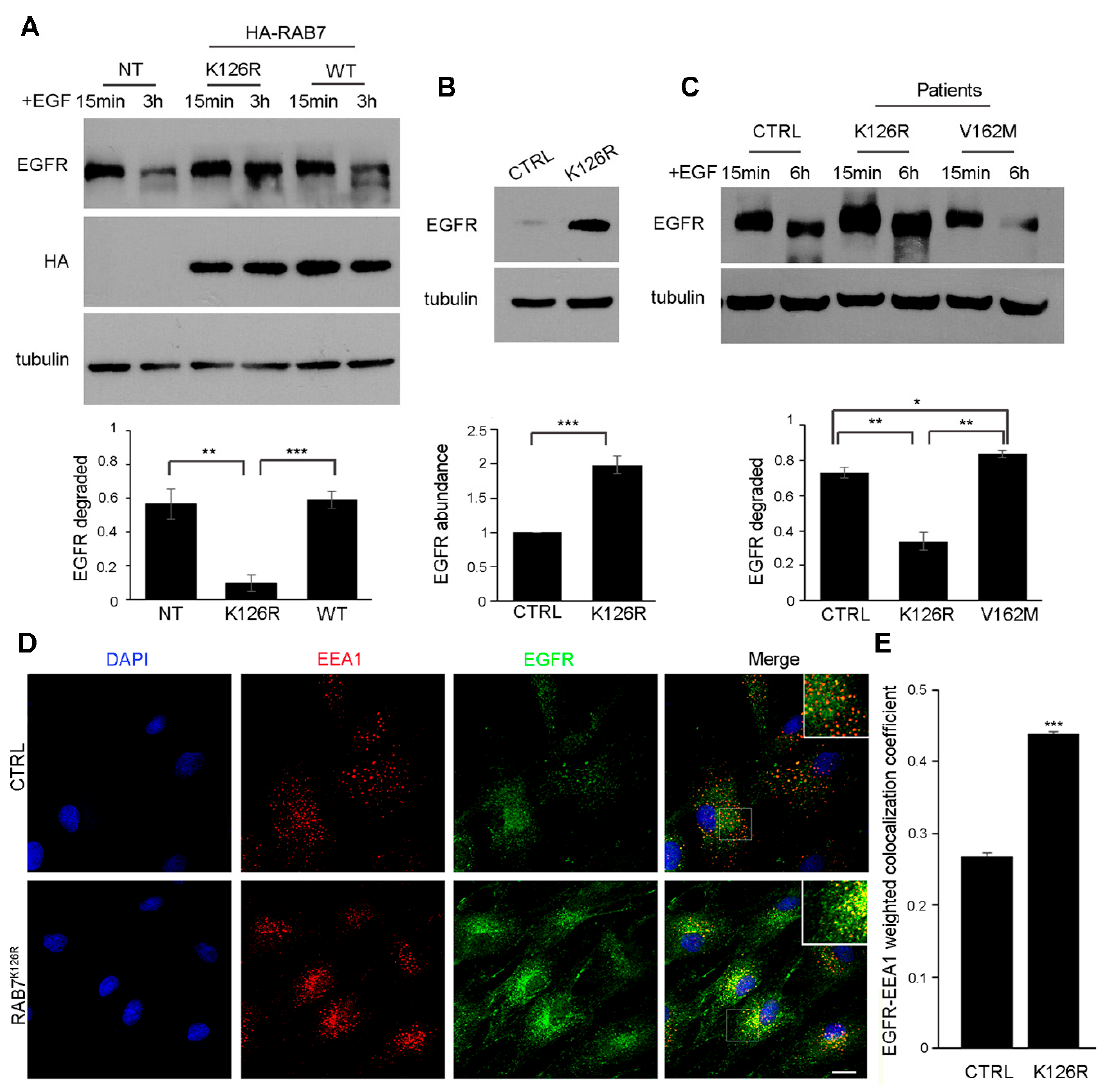
Figure 4. Expression of RAB7 K126R inhibits ligand-induced EGFR degradation affecting EGFR intracellular trafficking. ( A ) NCI-H1299 cells overexpressing HA-RAB7 K126R or HA-RAB7 wt were intracellular tra ffi cking. ( A ) NCI-H1299 cells overexpressing HA-RAB7 K126R or HA-RAB7 wt